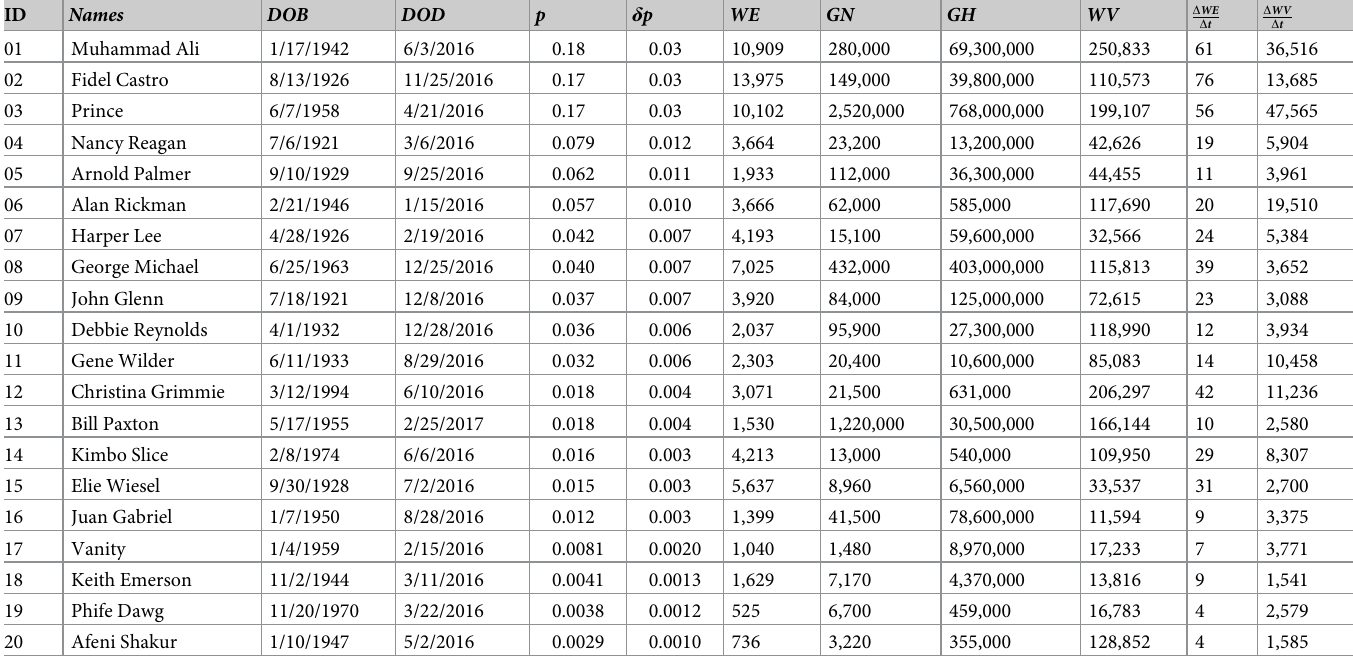
Table 1. Fame metrics for twenty renowned